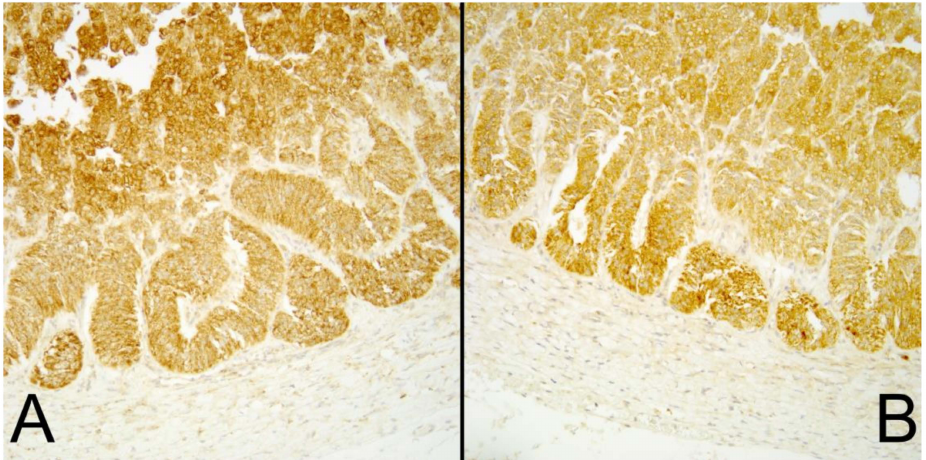
Figure 1. ( A ) Succinate dehydrogenase A (SDHA) and ( B ) Succinate dehydrogenase B (SDHB) immunoreactivity in normal canine adrenal glands as controls.